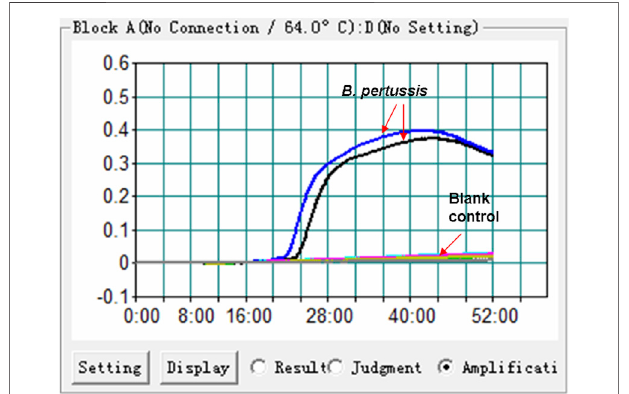
FIGURE 2 | Effectiveness of the primer set for the Bordetella pertussis loop-mediated isothermal ampli fi cation (LAMP) reaction. The DNA templates extracted from B. pertussis strains were effectively ampli fi ed with LAMP reaction at 64 ° C, while there was no reaction for the blank controls (distilled water,